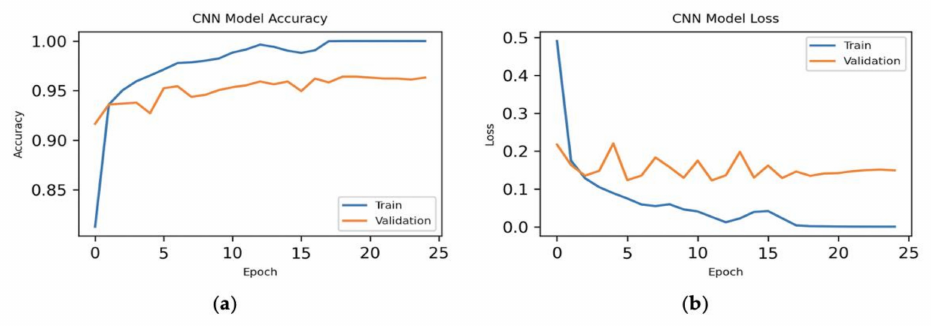
Figure 8. Experimental results for 92 features: ( a ) epoch vs. accuracy and ( b ) epoch vs.